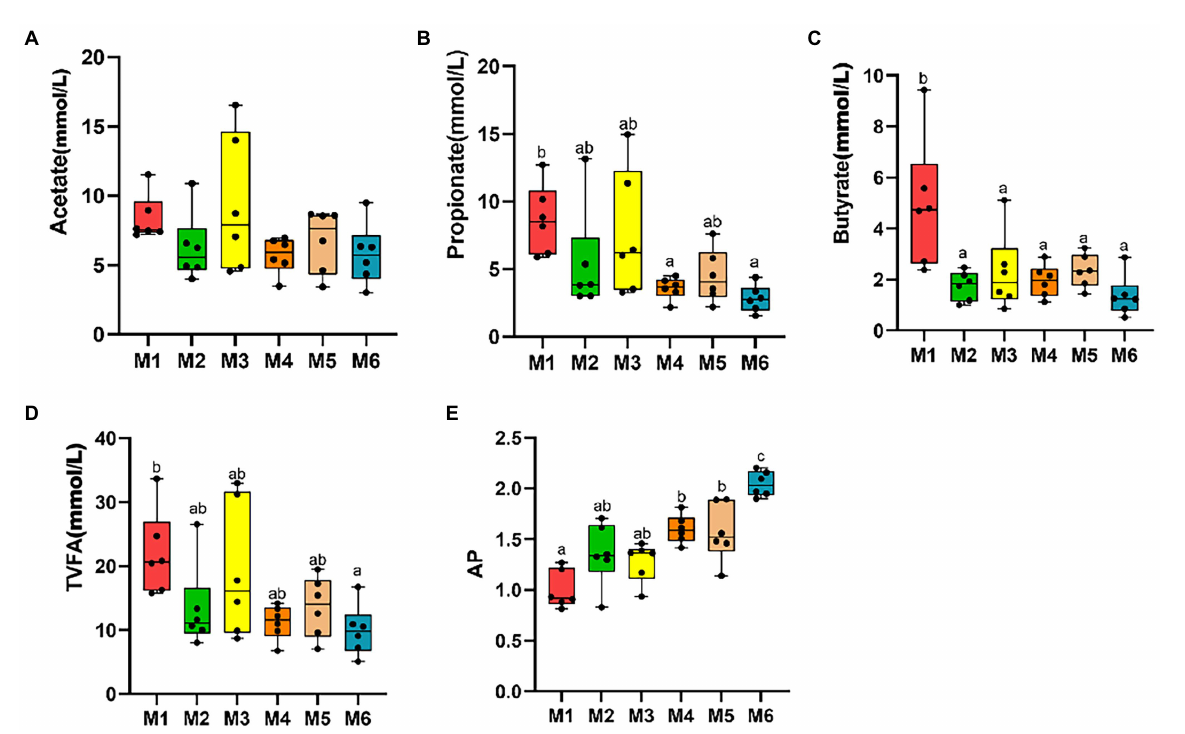
FIGURE 2 Effects of growth stage on fecal levels of volatile fatty acids (VFAs) in dairy calves. The following are shown in the figures: fecal levels of individual VFAs (A–C) , total volatile fatty acids (TVFA; D ), and acetate to propionate ratio (AP; E ). The results are presented as mean ± SEM. The differences among the six groups are represented by various letters ( p < 0.05); the number of calves in each of the six groups was